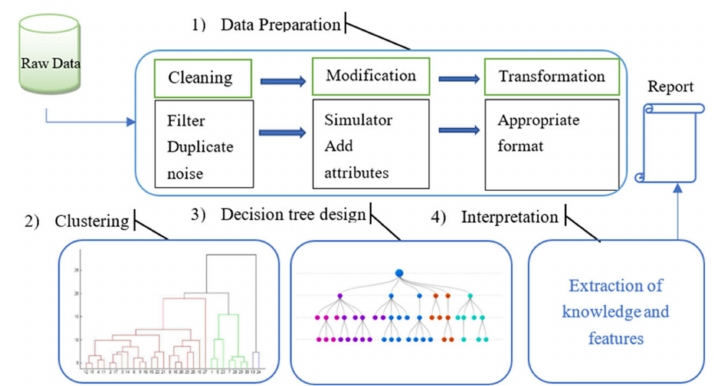
Figure 3. Modeling process.